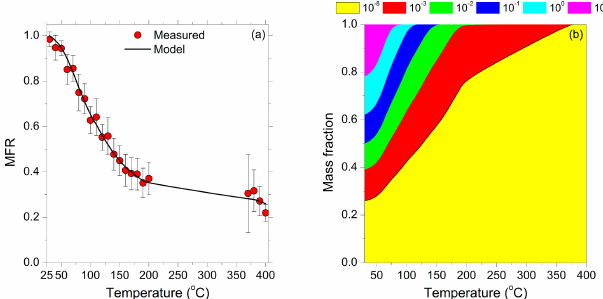
Figure 3. (a) Average loss-corrected total OA thermograms. Red circles represent the measured total OA mass fraction remaining (MFR) and the error bars the corresponding variability ( ± 2 standard deviations of the mean). The solid lines are the model predictions. (b) Mass fraction of the total OA for different effective saturation surrogate species, with concentrations as a function of thermode- nuder (TD) temperature. Yellow represents the contribution of the effective saturation concentration C ∗ = 10 − 8 µgm − 3 , red the con- tribution of the C ∗ = 10 − 3 µgm − 3 , green the C ∗ = 10 − 2 µgm − 3 , blue the C ∗ = 10 − 1 µgm − 3 , cyan the C ∗ = 10 0 µgm − 3 , and ma- genta the C ∗ = 10µgm − 3 .